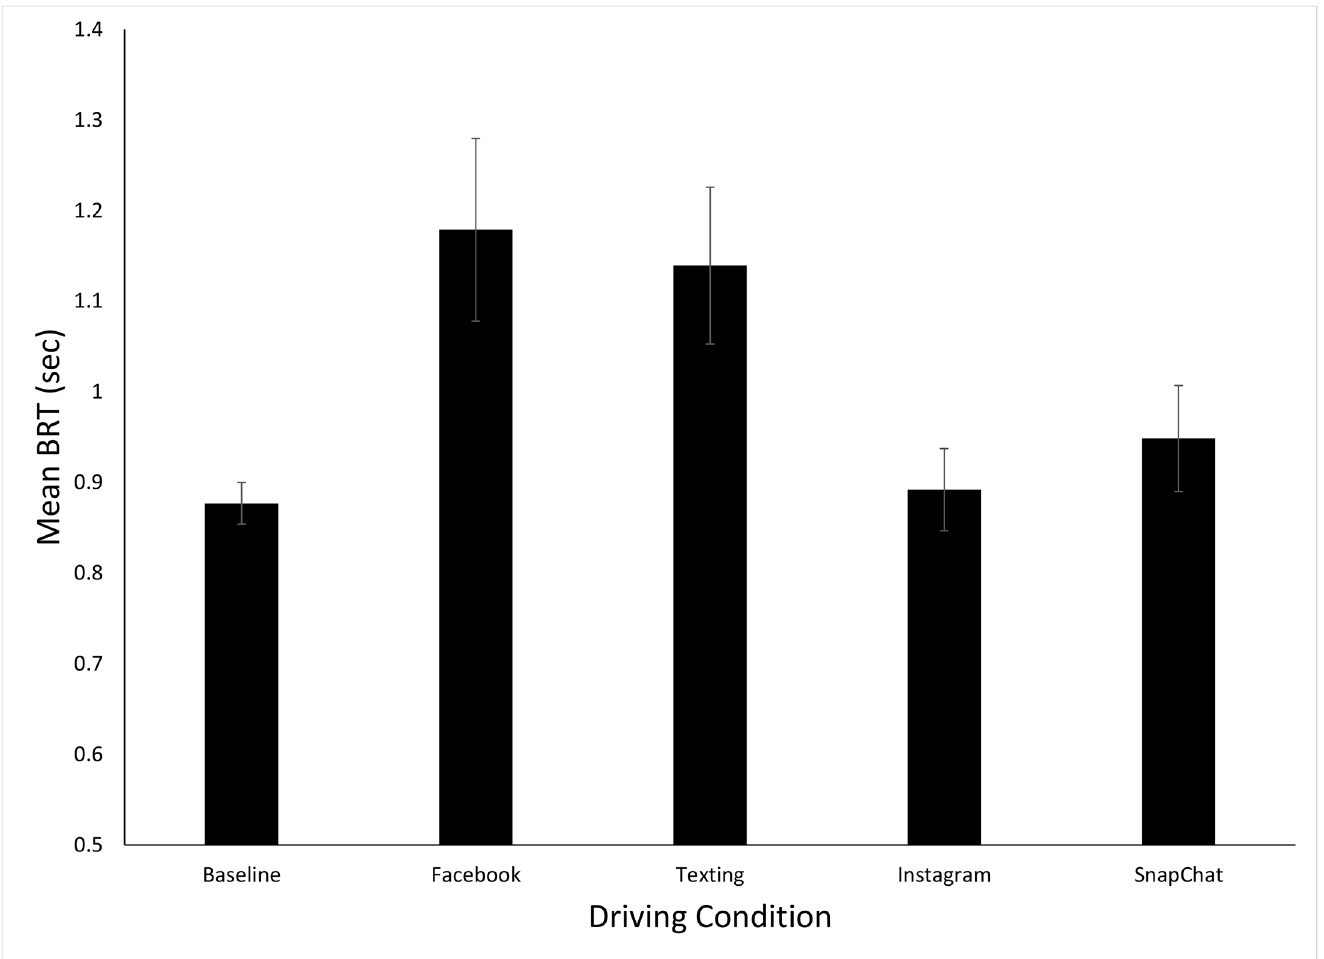
Fig 2. Mean brake reaction times (BRT) for the five different driving conditions. Error bars are standard